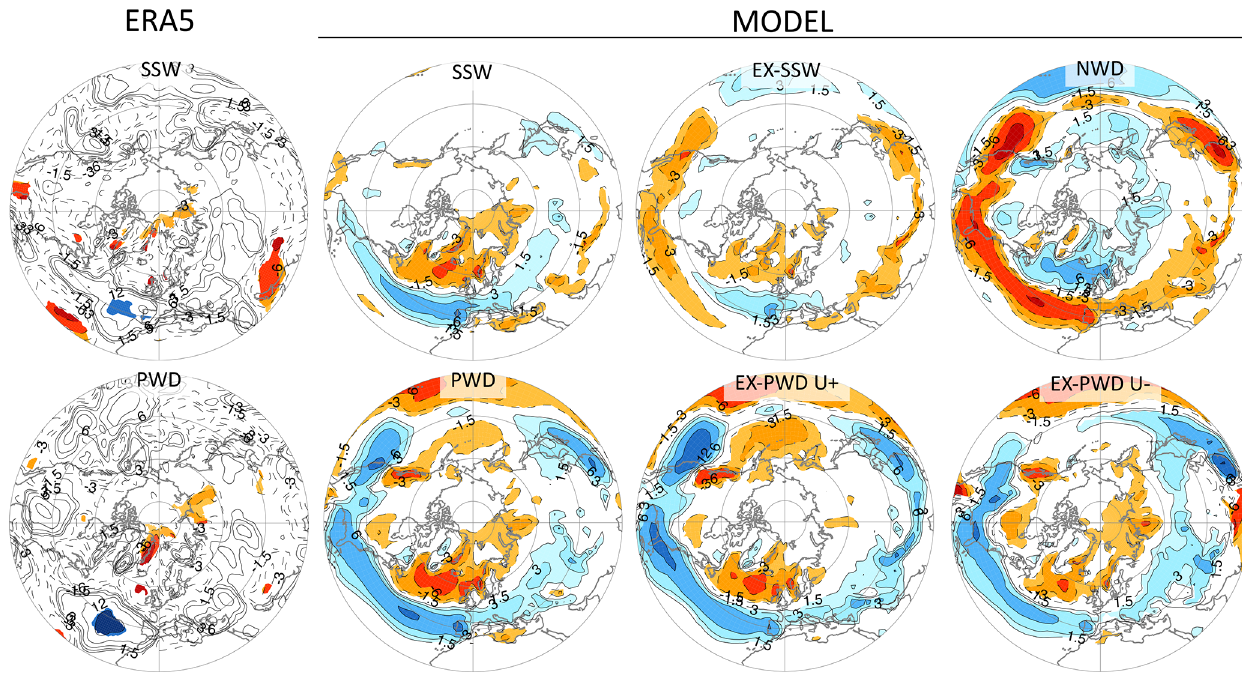
Figure A2. Like Fig. 8 but for precipitation. Contours are at ± 1 . 5, ± 3, ± 6, ± 12, and ± 24mm per month.